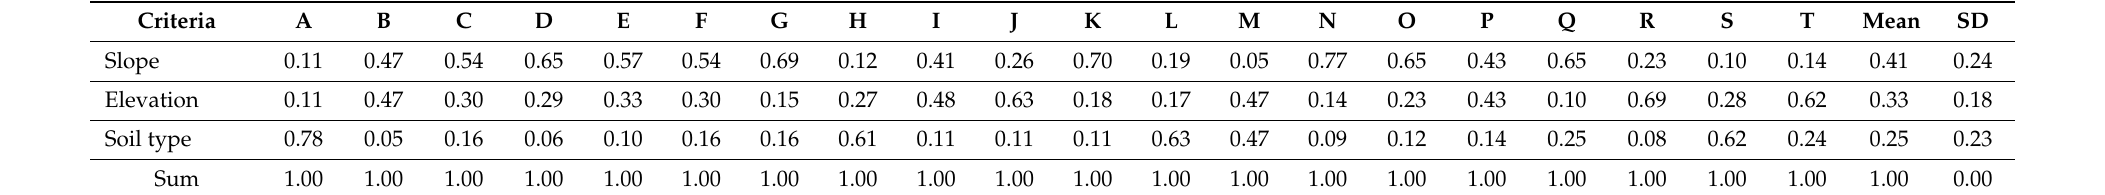
Table 7. Weights of the criteria for forest areas suitability mapping using